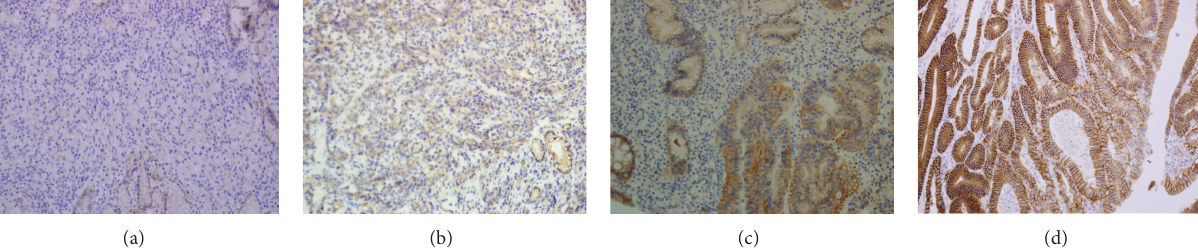
Figure 1: Immunohistochemical analysis of human epidermal growth factor receptor 2 protein expression (a–d). (a) Immunostaining shows no staining on tumor cell membrane. (b) Immunostaining shows positive reaction (1+). (c) Immunostaining shows positive reaction (2+). (d) Immunostaining shows positive reaction (3+) with complete or basolateral membraneous